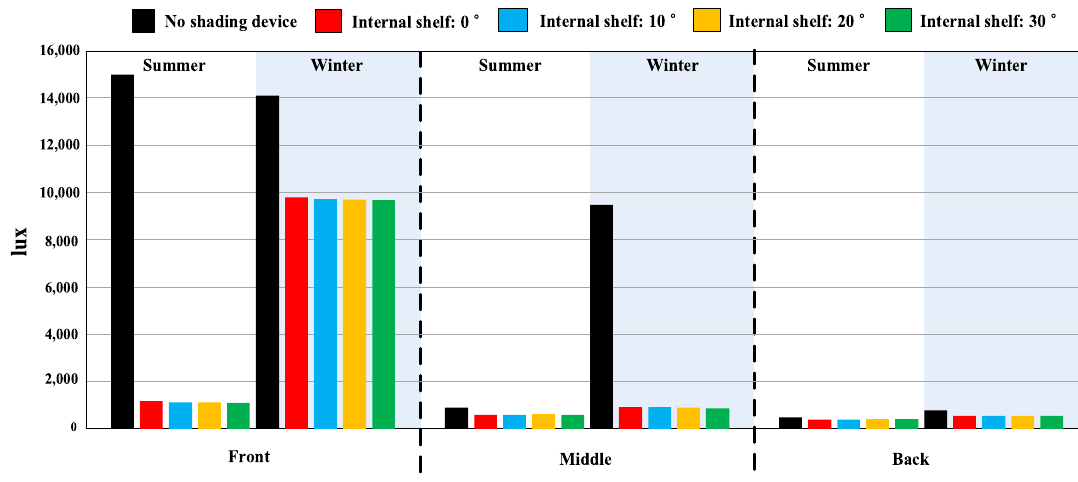
Figure 6. Daylighting performance through the light shelf.